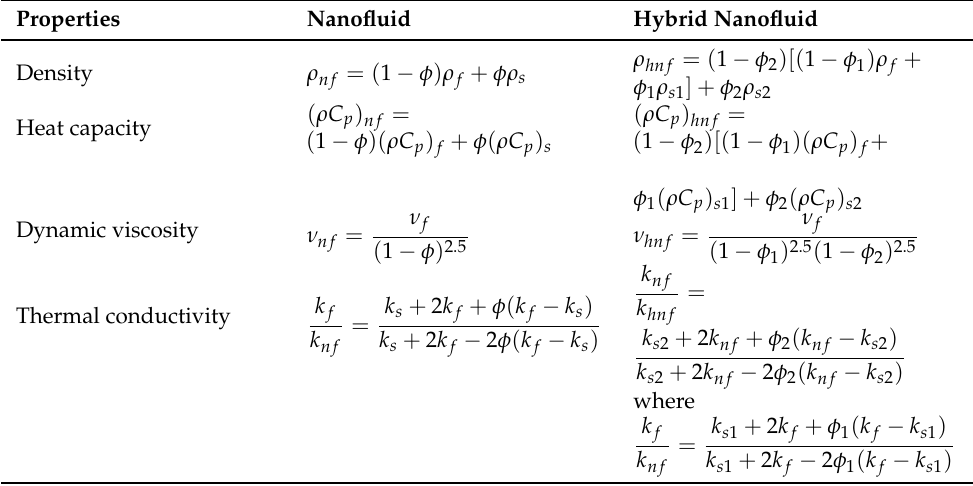
Table 1. Properties of nanofluids and hybrid nanofluids.